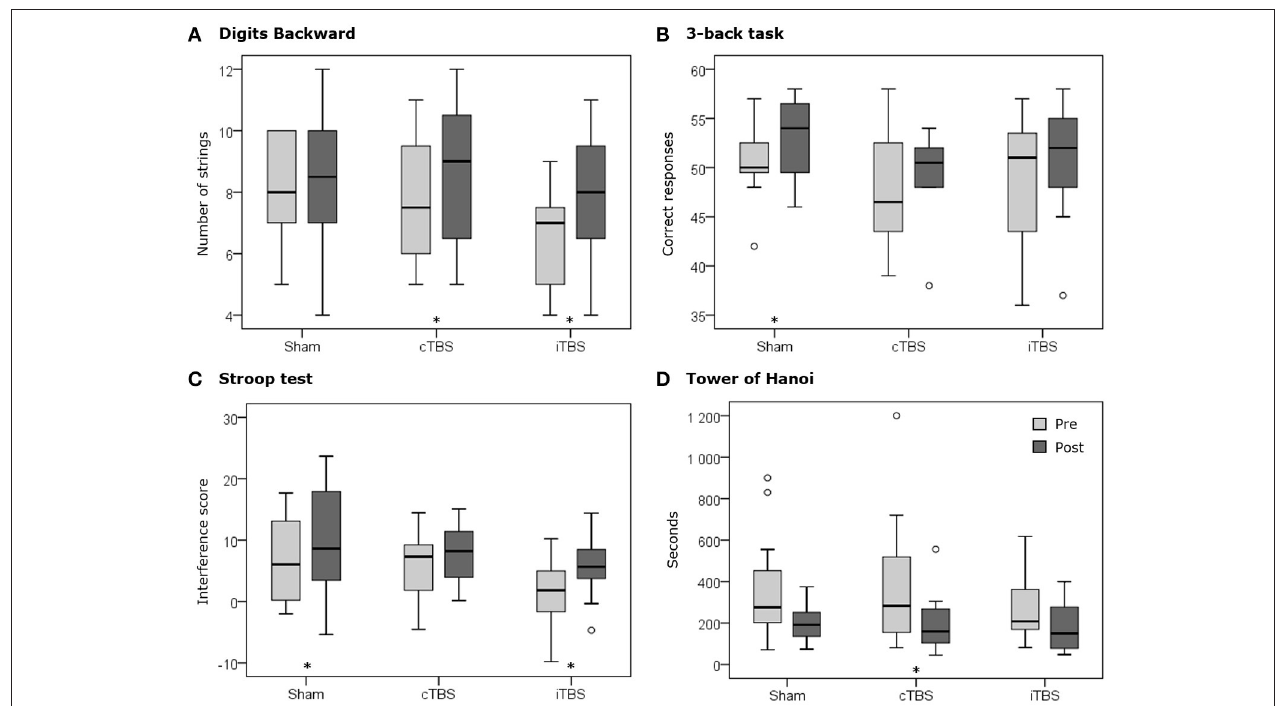
FIGURE 5 | Boxplots representing the pre (pale gray) and post (dark gray) distributions of each stimulation condition (i.e., sham, cTBS and iTBS) for (A) the number of strings completed in the Digits Backward test, (B) the number of correct responses in the 3-back task, (C) the interference score of the Stroop test, and (D) the time to complete the Tower of Hanoi. The asterisks (*) represent statistically significant differences ( p < 0.05) between pre- and post-TBS assessment in specific conditions and tests. Circles ( ◦ ) represent